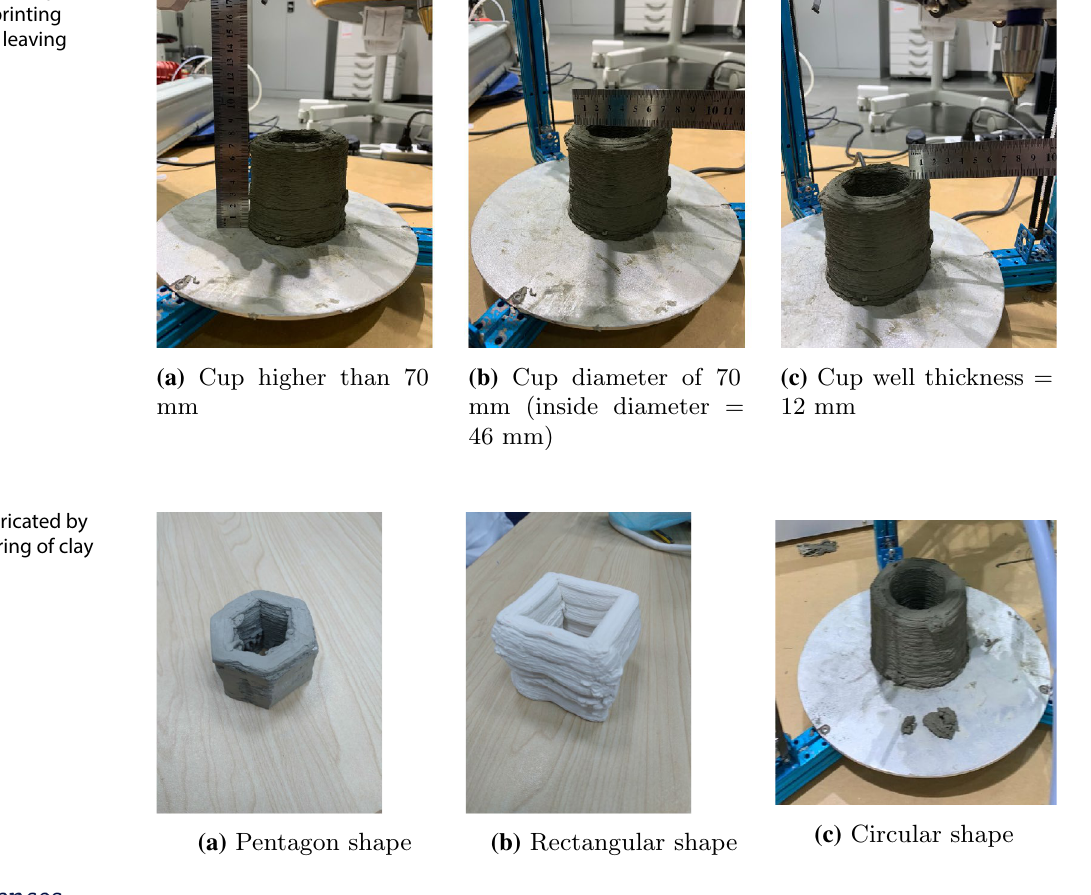
Fig. 10 The cylindrical cup made by direct 3D printing (without slump clay leaving the orifice)